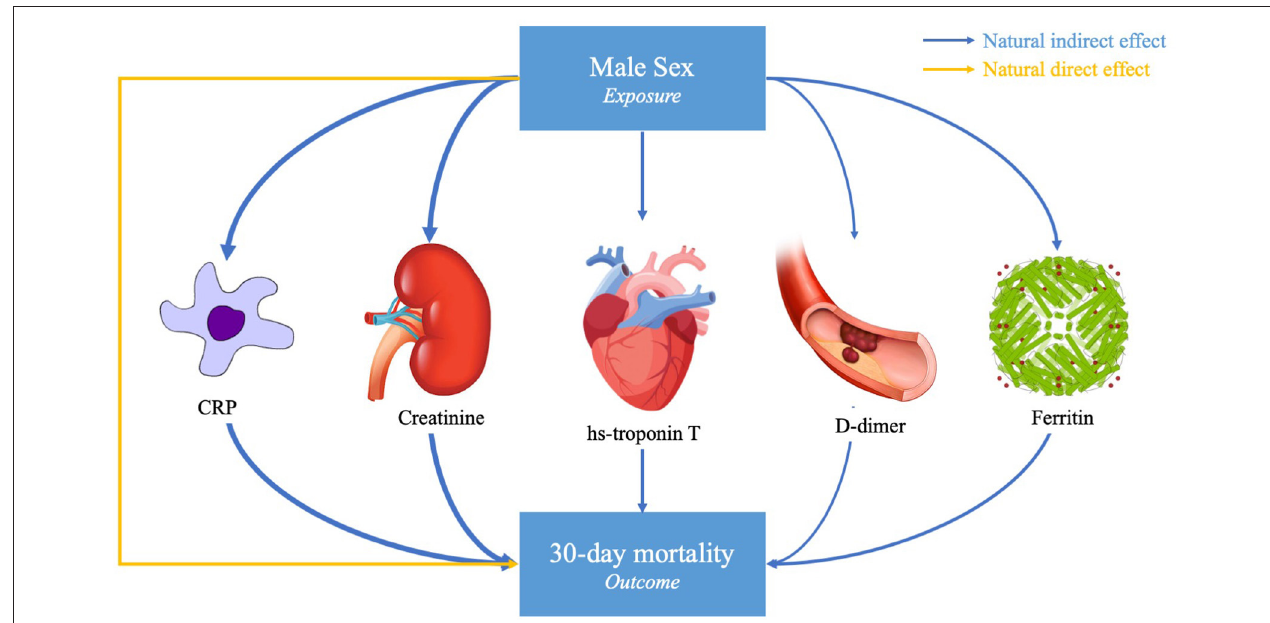
FIGURE 1 | Causal mediation model. This study assessed the degree to which peak serum biomarkers mediated the association between male sex and death due to SARS-CoV-2 infection in hospitalized patients. Of the fifteen biomarkers tested, five were significant mediators of the association between male sex and 30-day mortality, with varying proportion mediated as represented by the arrow thickness. Potential confounders accounted for in the primary analysis included age, sex, race/ethnicity, and number of biomarker measurements. The proportion mediated is given by the Natural Indirect Effect (NIE) divided by the Total Effect [NIE + Natural Direct Effect